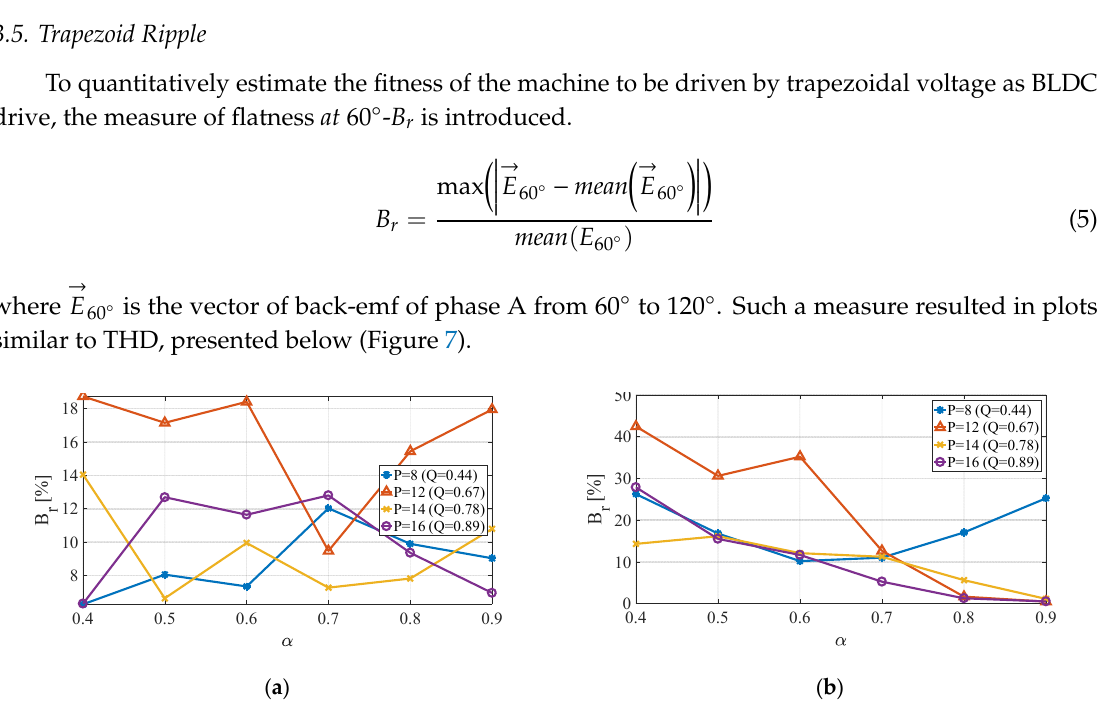
Figure 7. Line to line ( a ) and phase ( b ) back-emf deviation from 60° trapezoid.